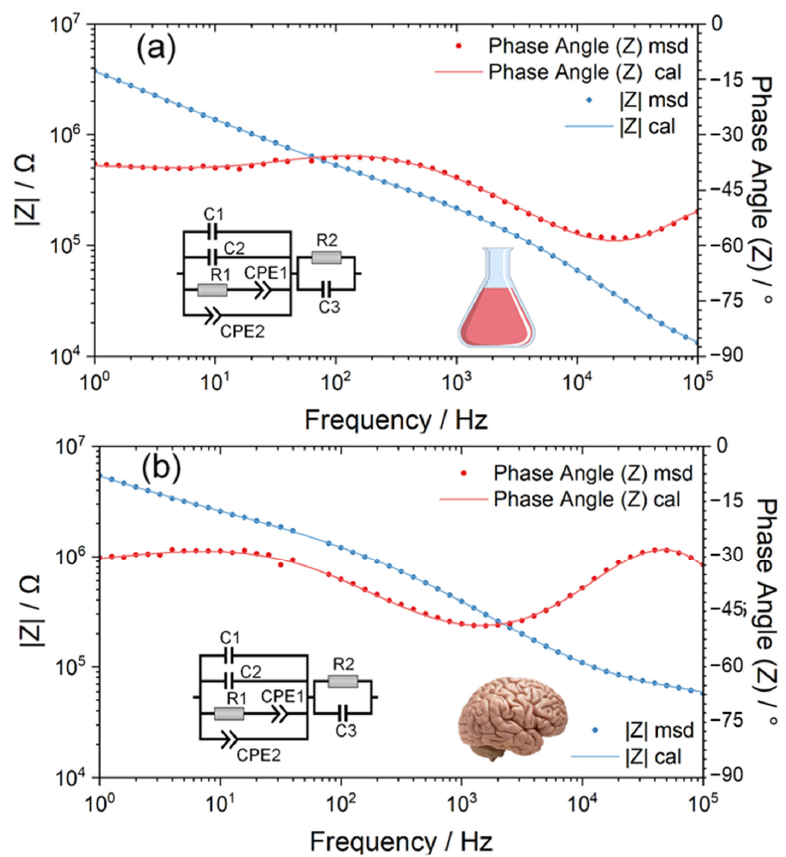
Figure 3. The electrochemical impedance spectroscopy (EIS) of the Pt wire neural electrodes was measured in normal saline ( a ) and pig brain in vitro ( b ), and the inserted diagrams are their corresponding equivalent circuit models.